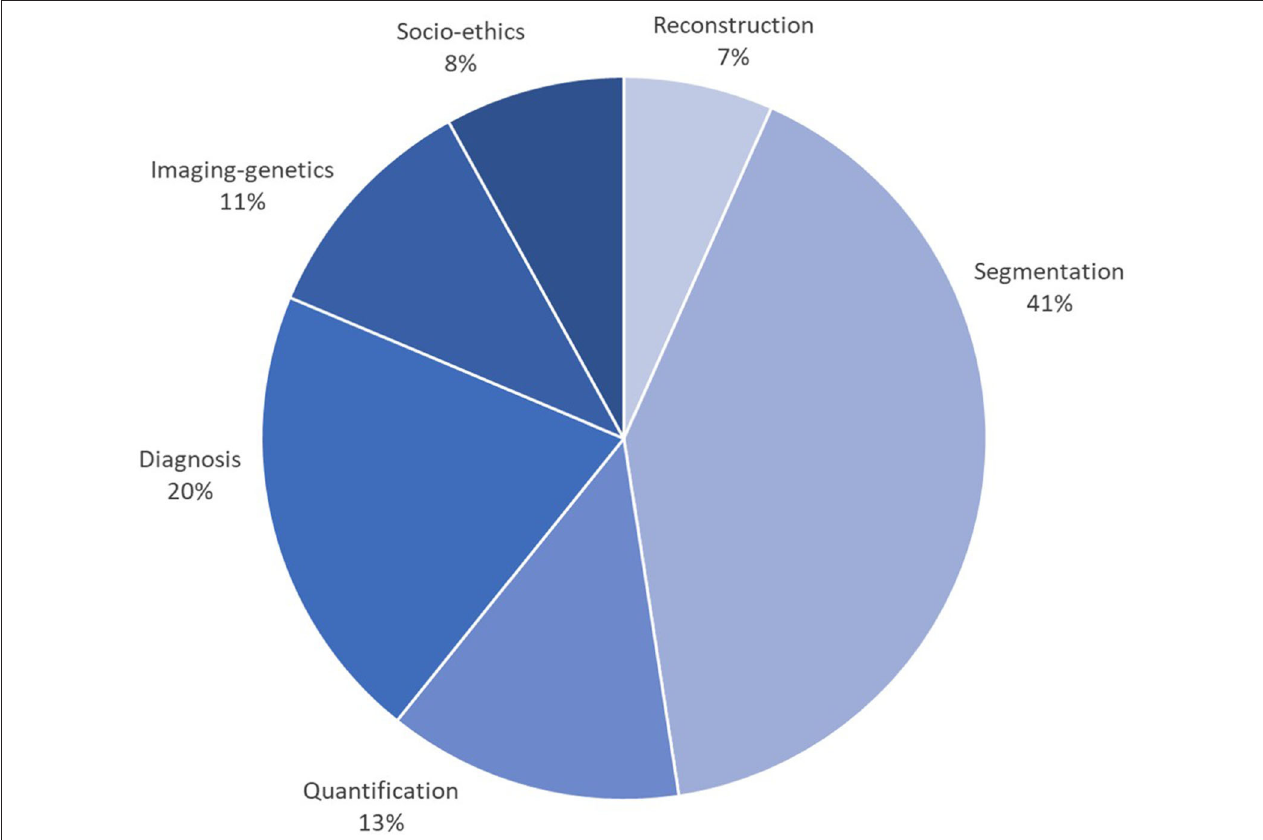
FIGURE 3 | Percentage of papers surveyed per cardiac imaging task, showing that approx. 40% of efforts have been dedicated to segmentation, followed by diagnosis (20%), then shape and motion quantification (13%). The subfigures are taken from the different papers in this special